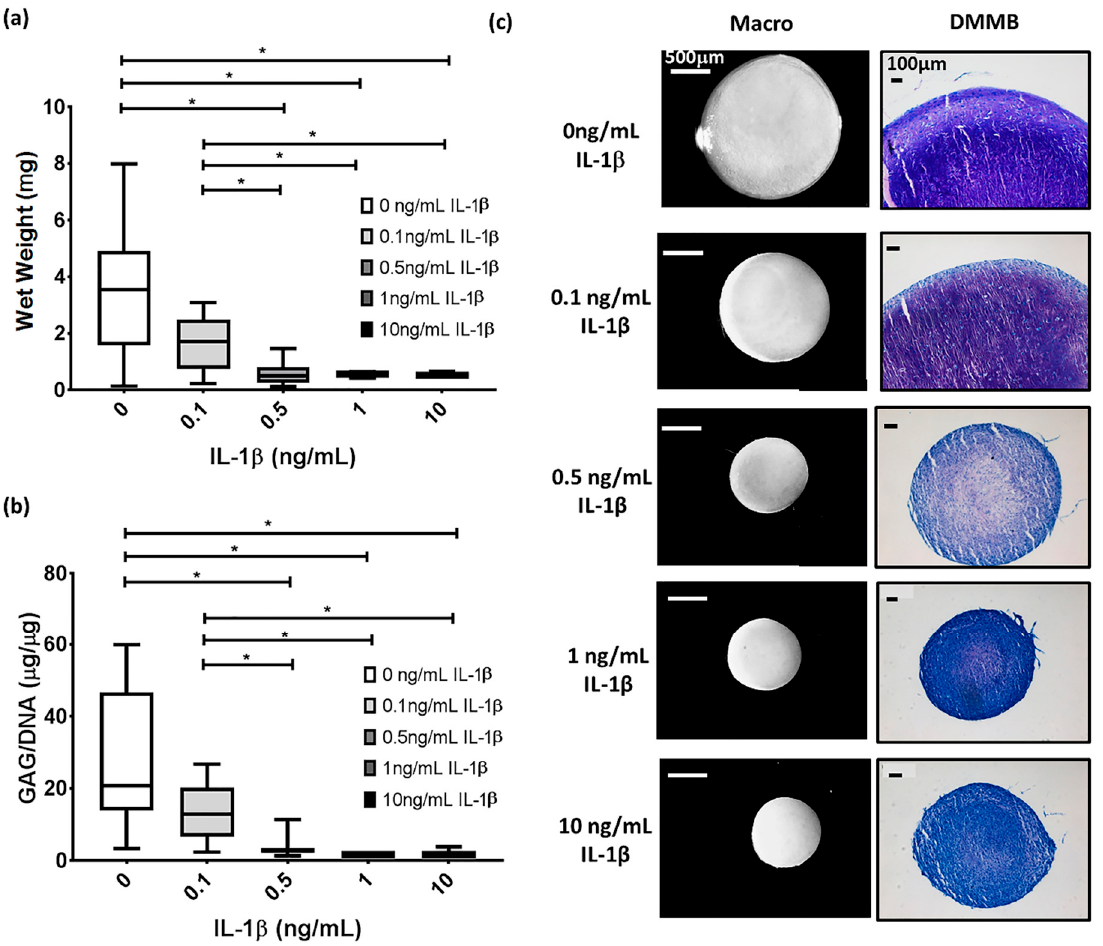
Figure 1. IL-1 β dose response under hyperoxic conditions during chondrogenesis, examined for pellet ( a ) wet weight and ( b ) GAG content. Box plots represent median ± I.Q.R; n = 3–12 donors; * p < 0.05; ( c ) Representative macroscopic and DMMB-stained chondrogenic pellets under the range of IL-1 β concentrations used.